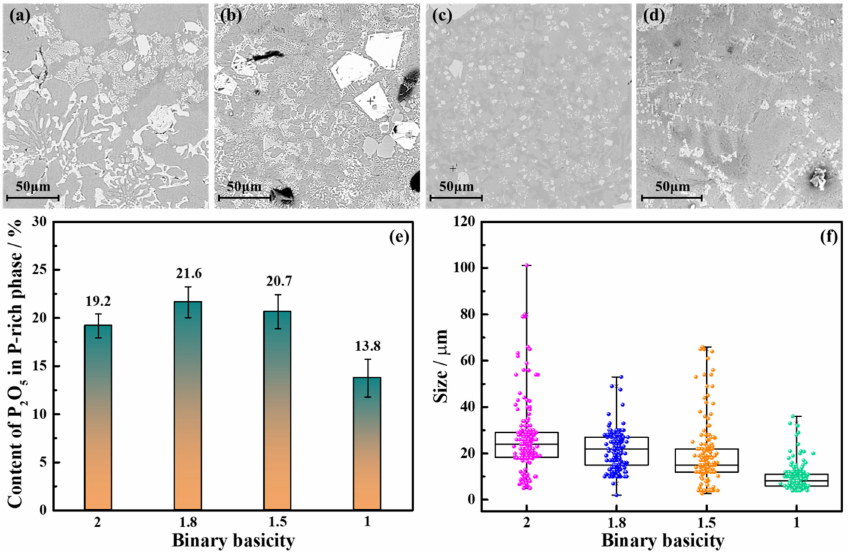
Figure 4. ( a – d ) Microscopic appearance of high phosphorus steel slag ( e ) P 2 O 5 content and ( f ) size of the phosphorus-rich phase under different binary